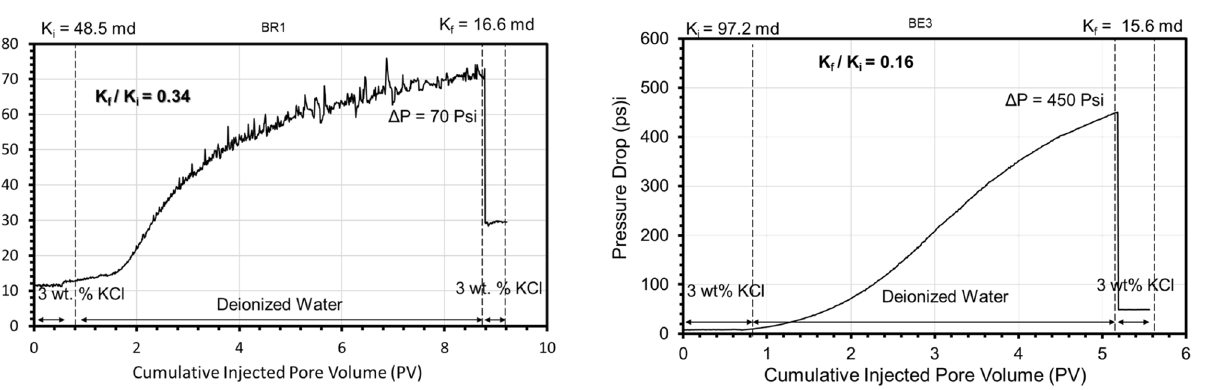
Fig. 1 Pressure drop across the sample Bandera Grey sandstone (BR1) as the deionized water injected at 5 cm 3 /min (backpres- sure = 1000 psi, confining pressure = 1700 psi)